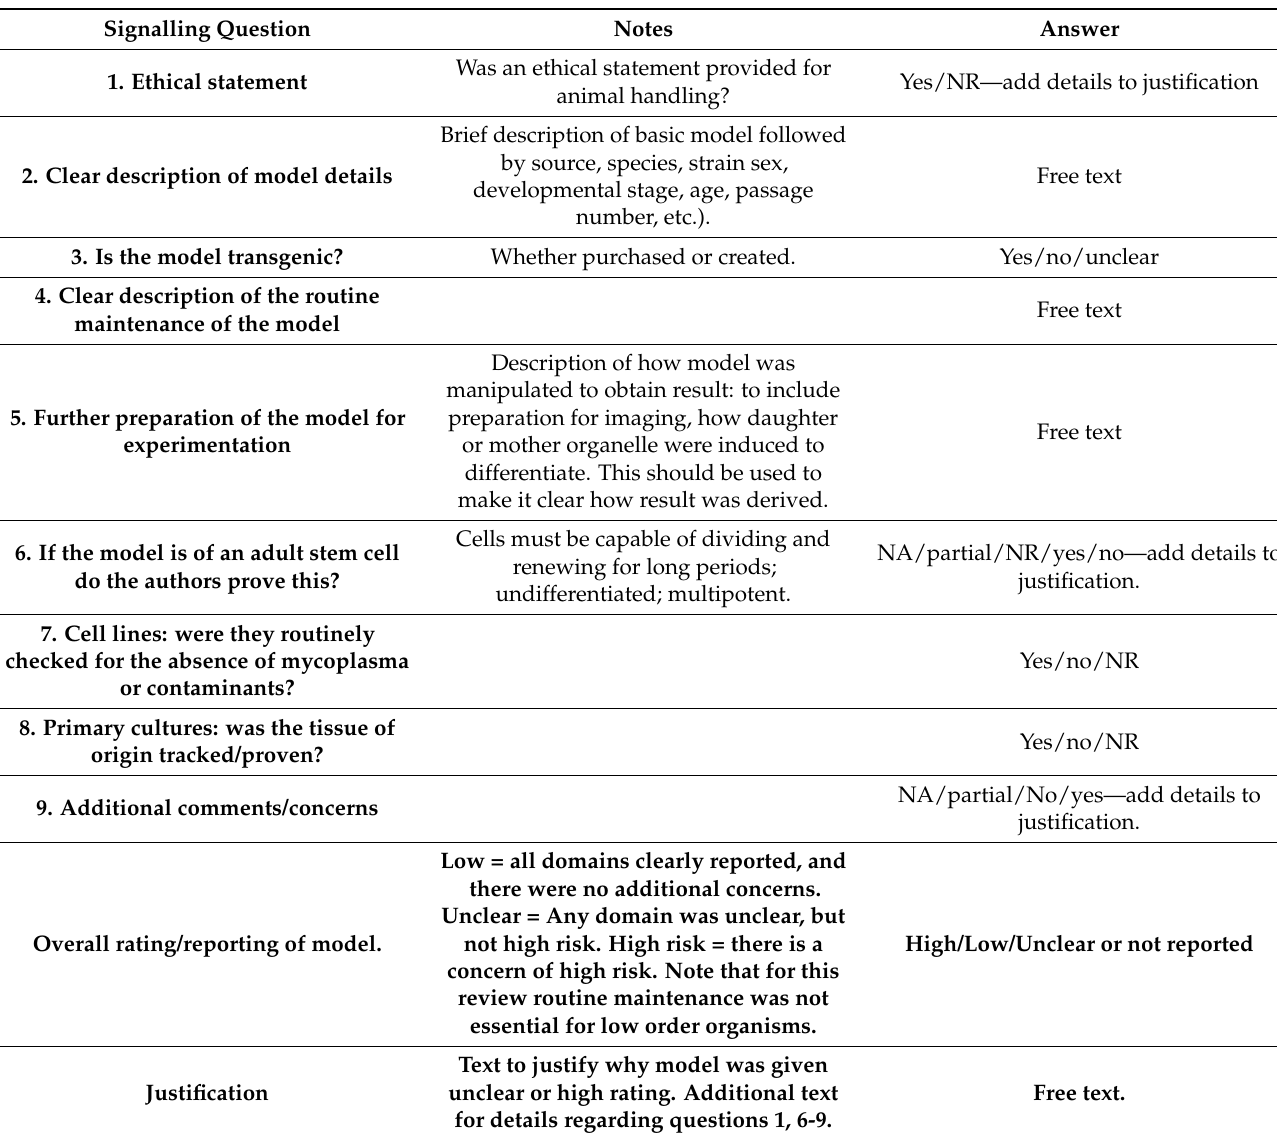
Table A4. Model validity